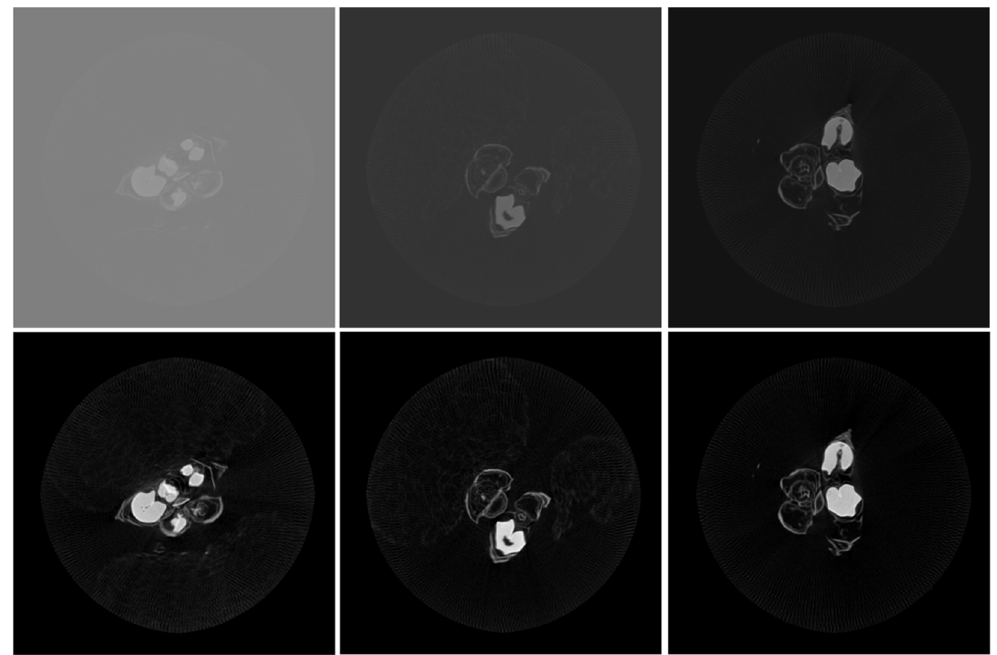
Figure 7. Image intensity equalization. Top three are images of different wheat spikes with different intensities, while the bottom three are equalized images correspondingly.